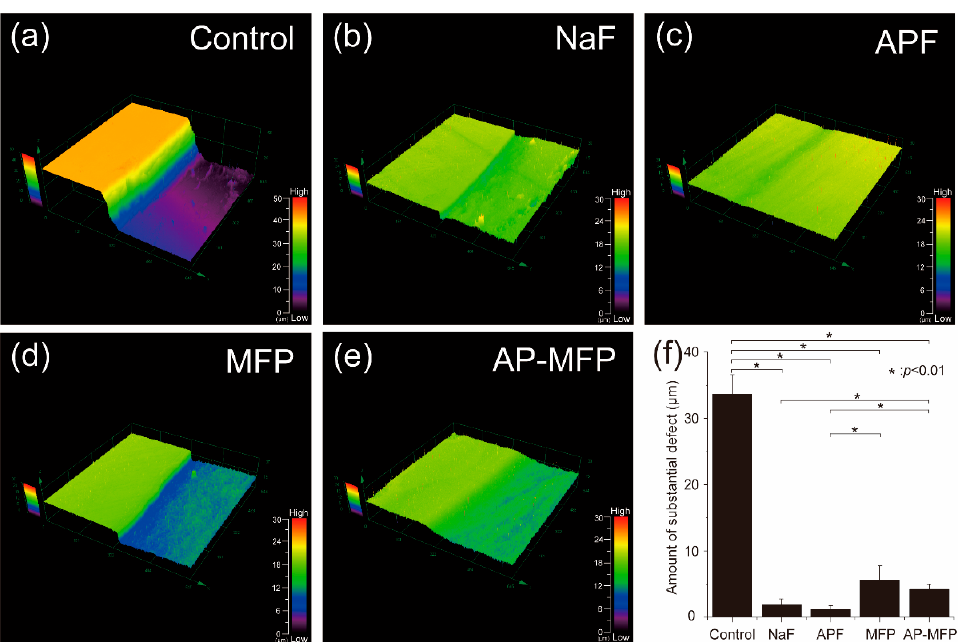
Figure 1. Height difference profiles measured using a 3D laser microscope. Boundary images of the reference and experimental surfaces of the samples from the ( a ) control (not fluoride treated), ( b ) NaF (9048 ppmF, pH 7.0), ( c ) APF (9048 ppmF, pH 3.6), ( d ) MFP (9048 ppmF, pH 7.0), and ( e ) AP-MFP (9048 ppmF, pH 3.6) groups after the acid challenge. The left side of Figure ( a – e ) shows the RS protected by wax and not demineralized. The right side shows the ES that has been demineralized. ( f ) Graphical representation of the substantial defects due to demineralization (n = 8, * p < 0.01).